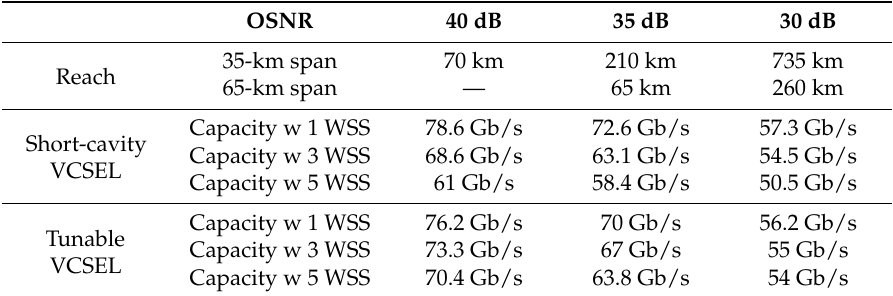
Table 2. Transmitted capacities and SSMF reach for SSB DMT as a function of: span length, VCSEL type/chirp, and number of crossed WSS.